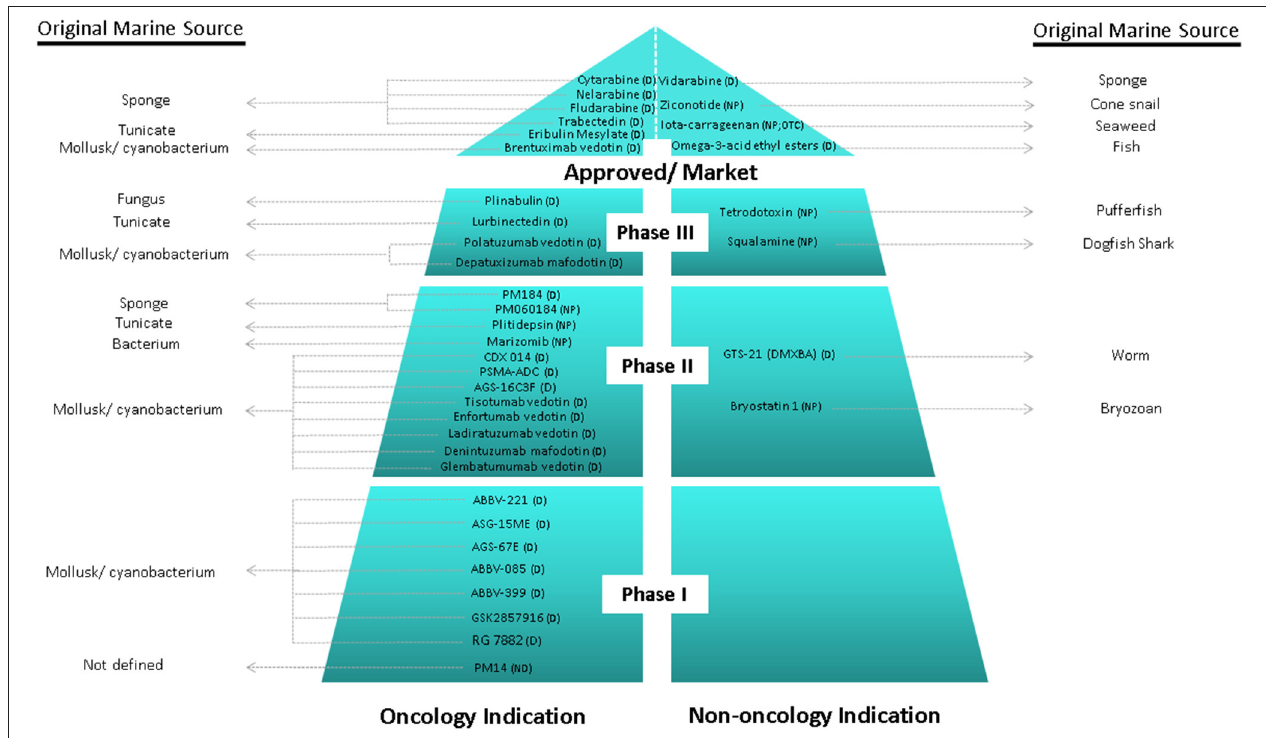
FIGURE 2 | Current clinical pipeline of marine-derived drugs and their original marine source. NP, Natural product; D, Derivate; OTC, Over-the-counter (AndisInsight, 2018; Calado et al., 2018; EMA, 2018a,b; FDA, 2018a,b; Mayer, 2018).